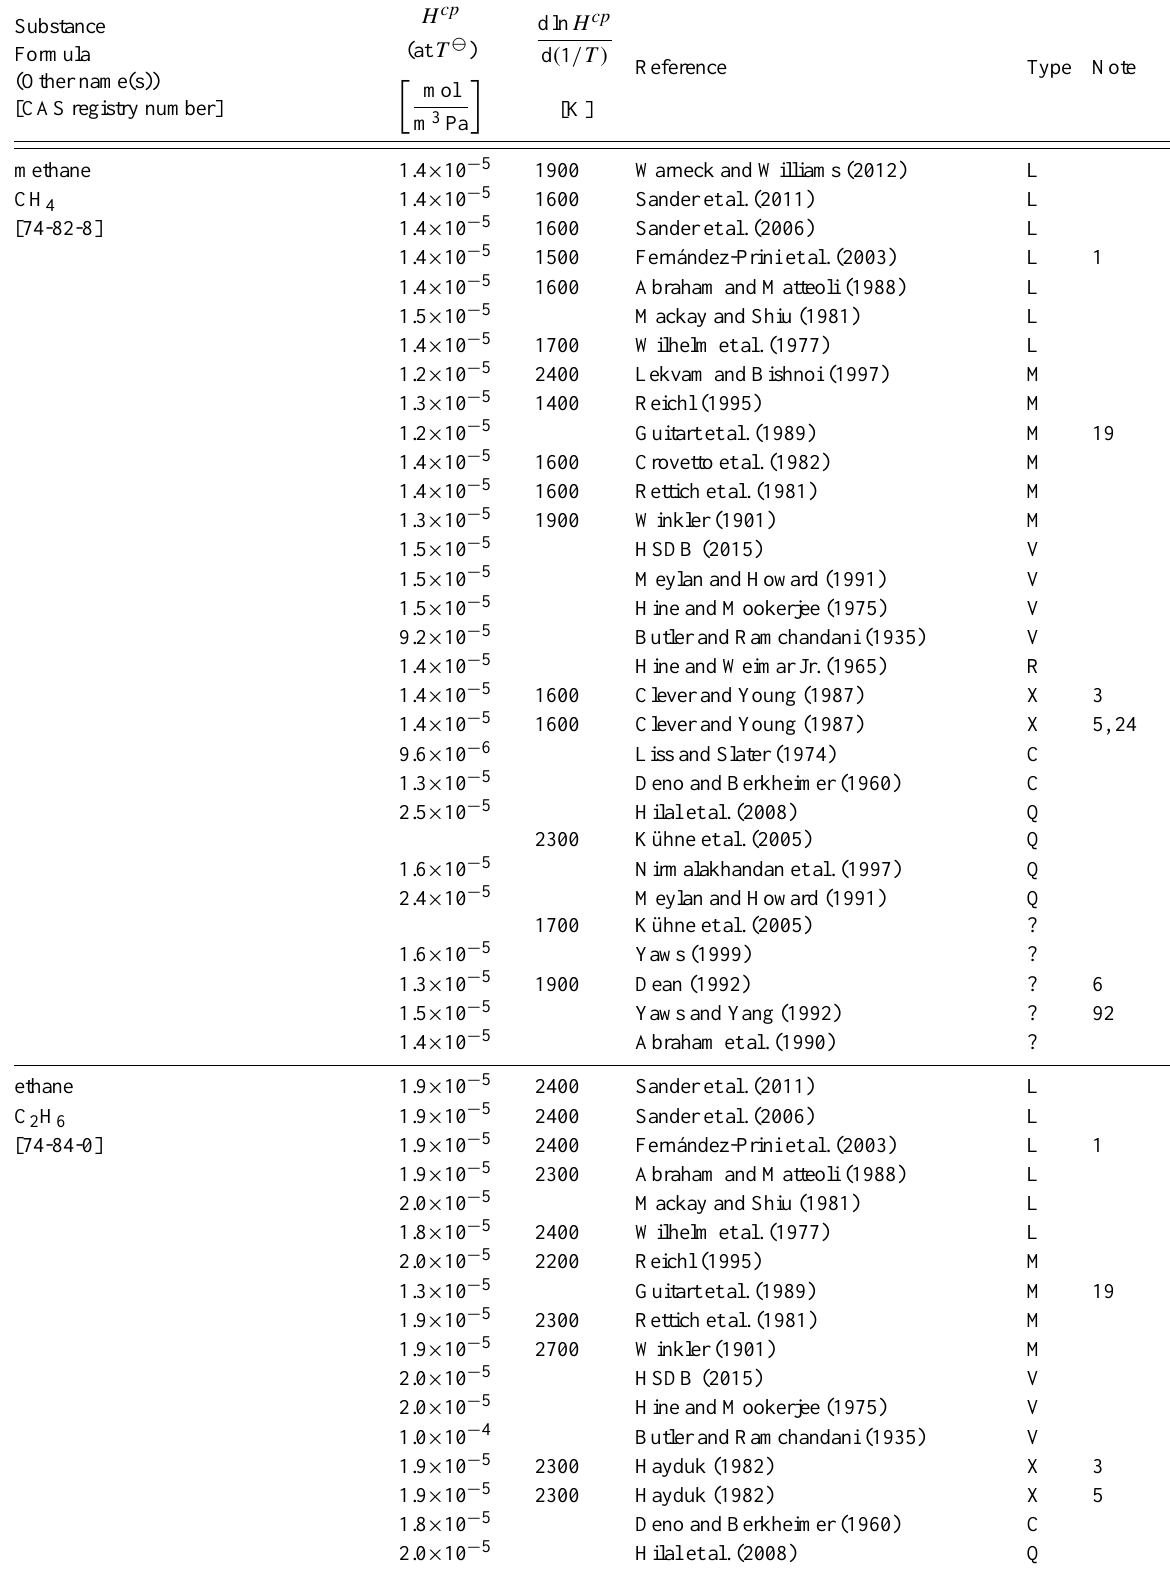
Table 6: Henry’s law constants for water as solvent